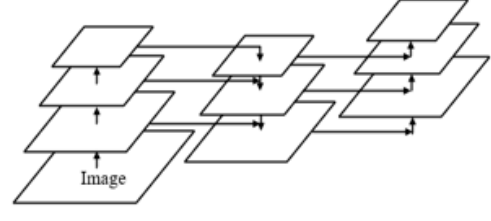
Figure 2. The structure of PANet.